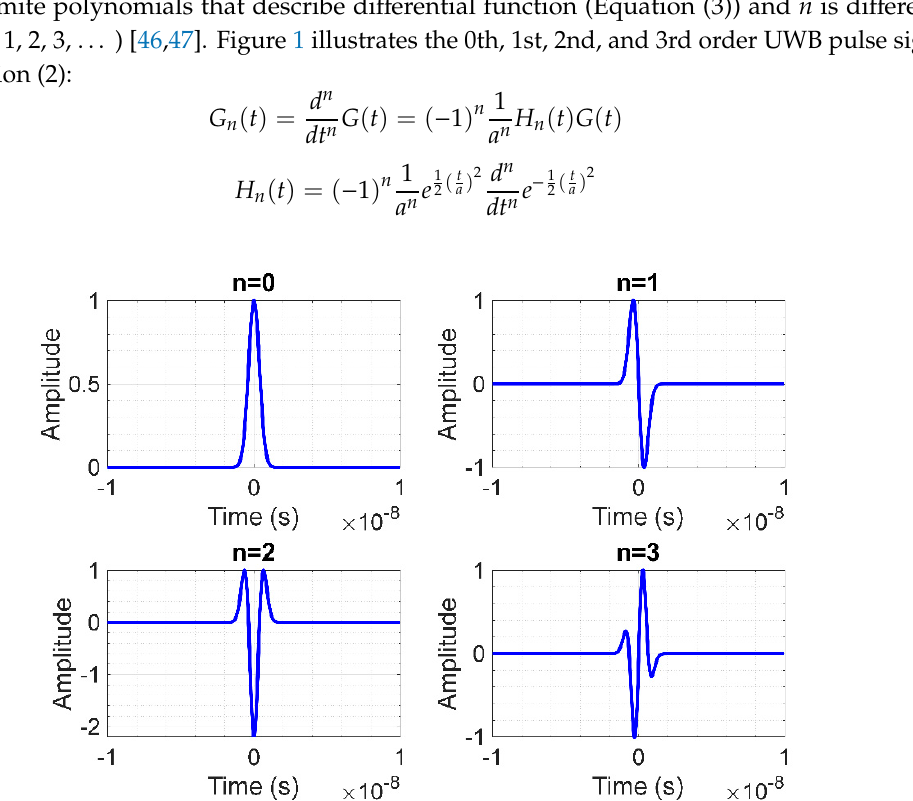
Figure 1. UWB pulse signals of 0th, 1st, 2nd, and 3rd order differential Gaussian distribution function.